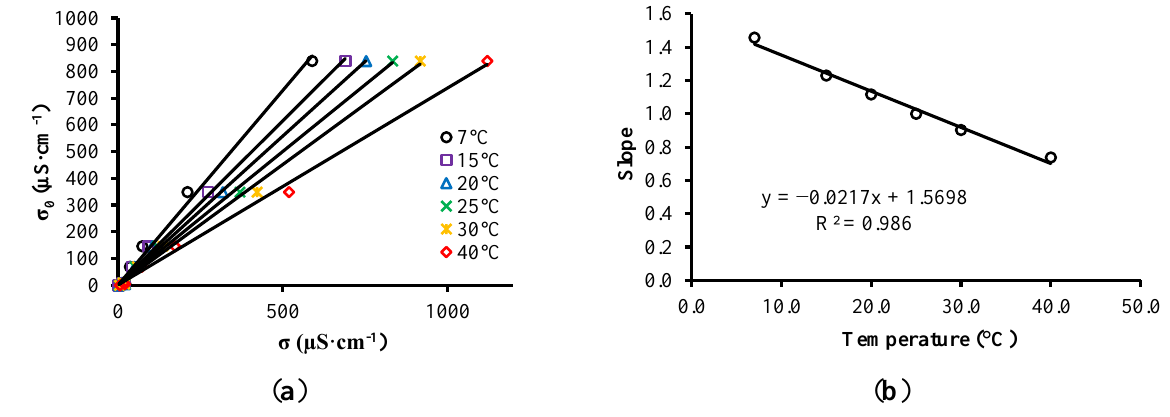
Figure 6. ( a ) σ-σ 0 relationship; ( b ) Correlation between temperature and slope of the fitted models for each